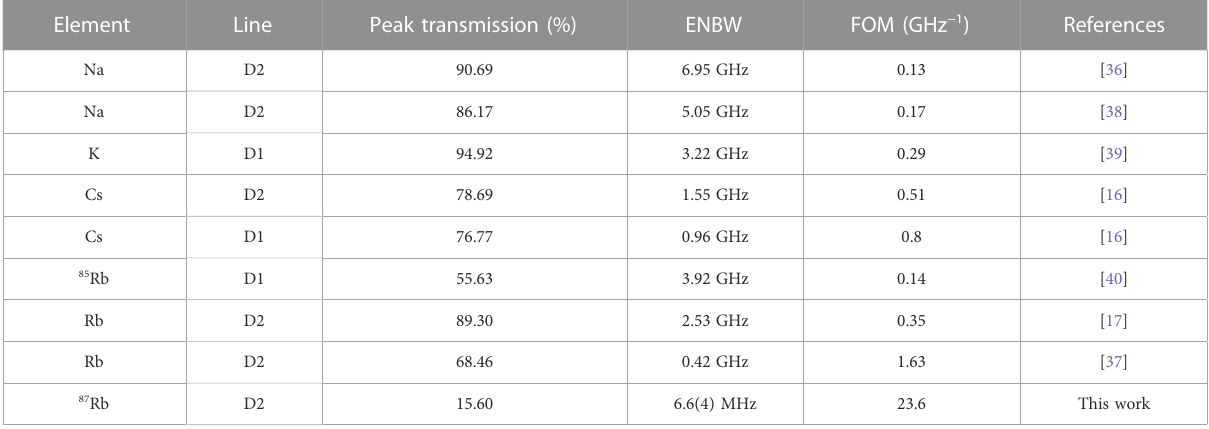
TABLE 2 Peak transmission, ENBW, and FOM parameters for different fi lters.